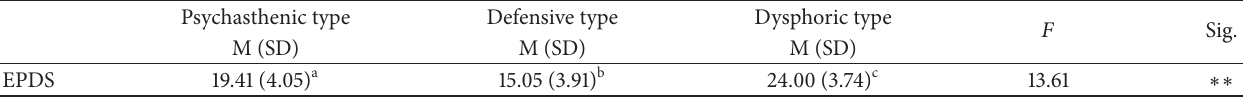
Table 4: EPDS: mean scores and standard deviations of three groups